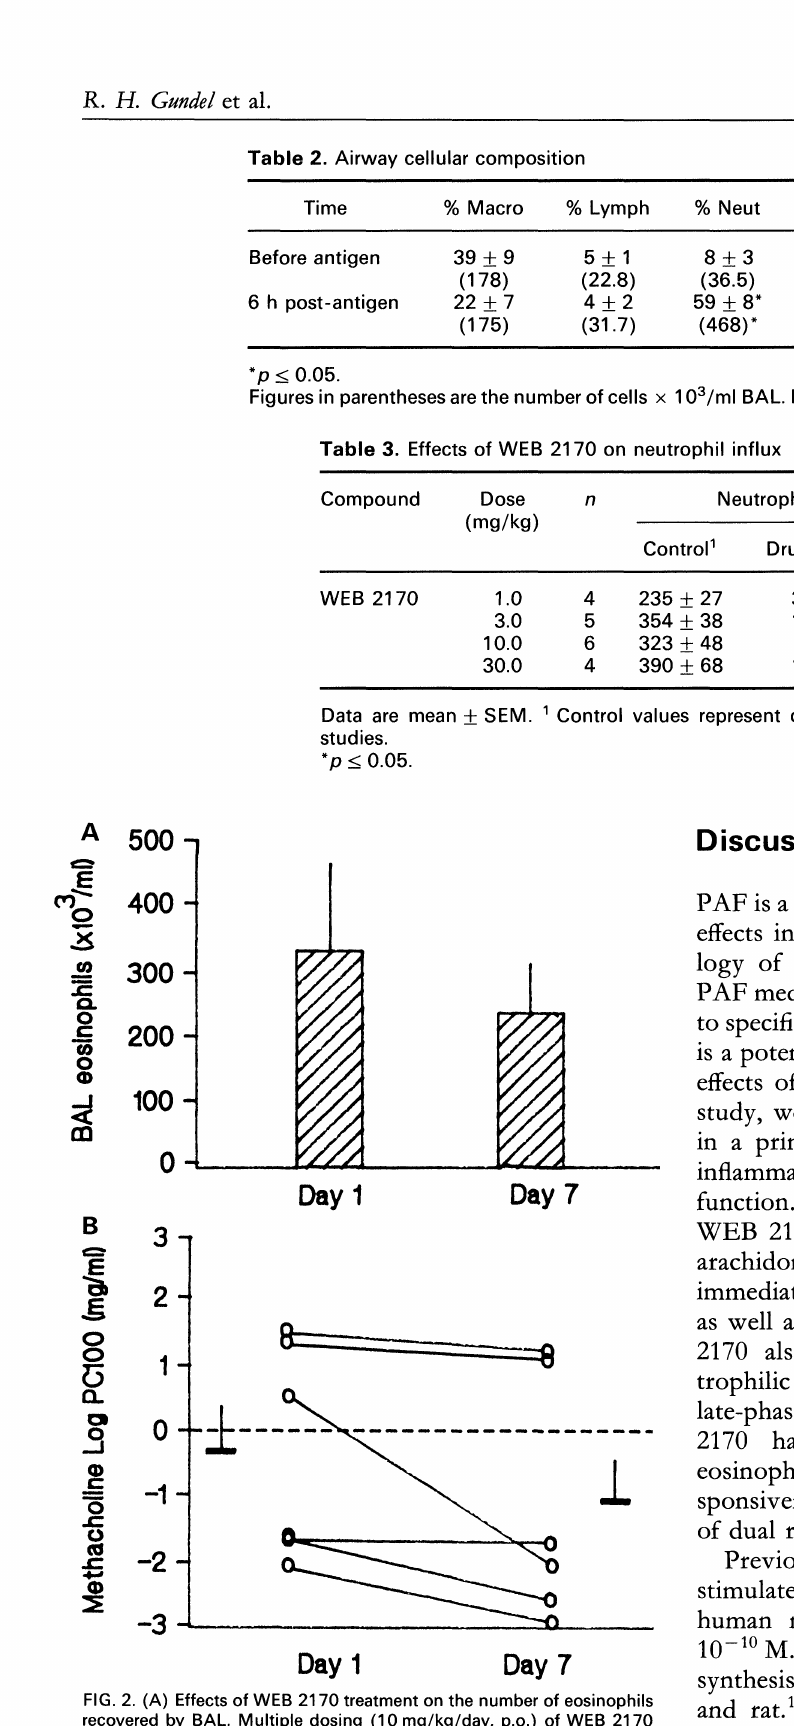
FIG. 2. (A) Effects of WEB 2170 treatment on the number of eosinophils recovered by BAL. Multiple dosing (10 mg/kg/day, p.o.) of WEB 2170 had no effect on the number of resident eosinophils in the airways of dual responder primates. Data are the mean -t- SEM, n 6. (B) Airway responsiveness to inhaled methacholine prior to multiple dosing with WEB 2170 (day and after (day 7). WEB 2170 treatment showed no improvement in airway hyperresponsiveness to inhaled methacholine. Individual data for each animal are shown as well as the mean SEM for the